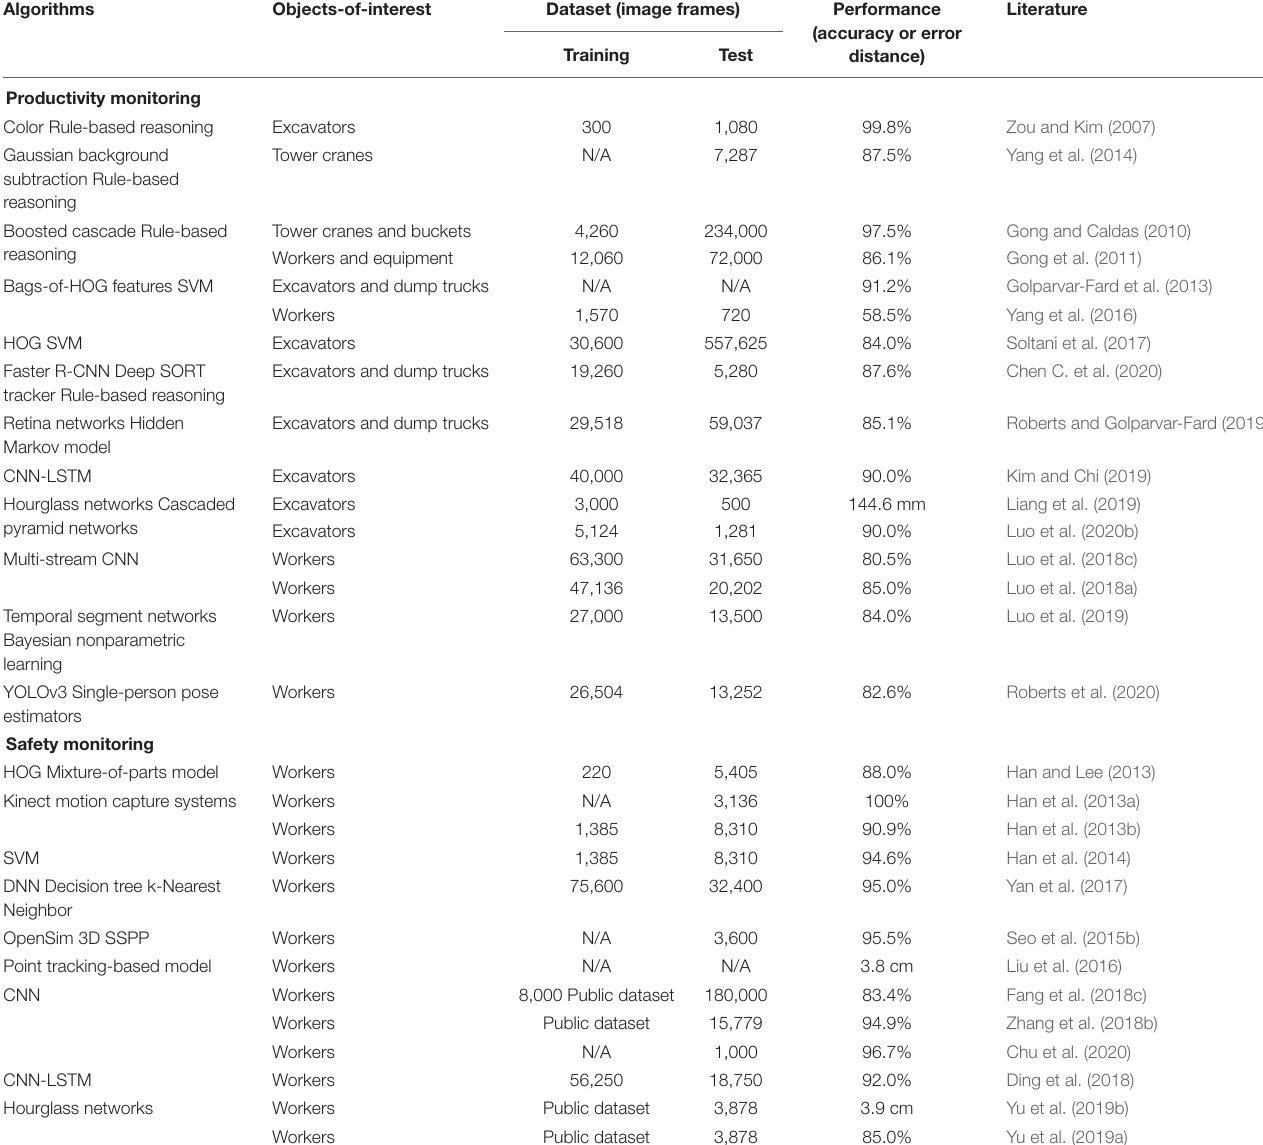
TABLE 2 | Summary of existing action recognition algorithms in